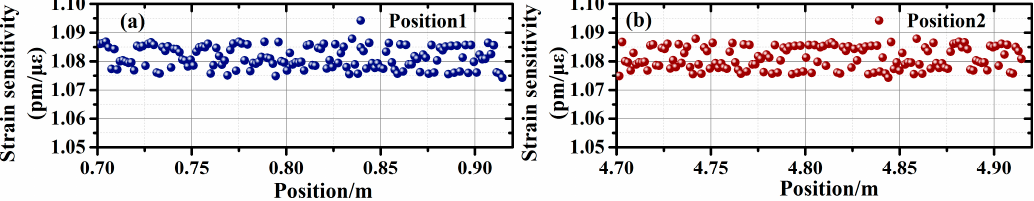
Figure 5. Comparison of the three techniques with distributed strain sensing: ( a ) linearity of strain sensing characterized by the R-square value; ( b ) wavelength demodulation accuracy.